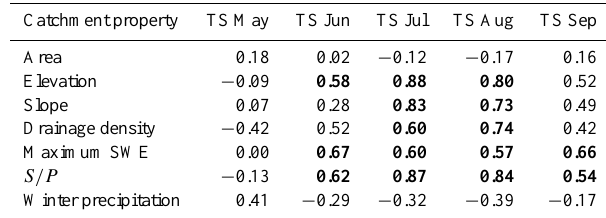
Table 3. Spearman rank correlation coefficients for the relation be- tween catchment properties and Theil–Sen slopes (TS), which were computed for assessing the low-flow sensitivity to peak SWE. Sta- tistically significant correlations (at the 0.05 level) are shown in